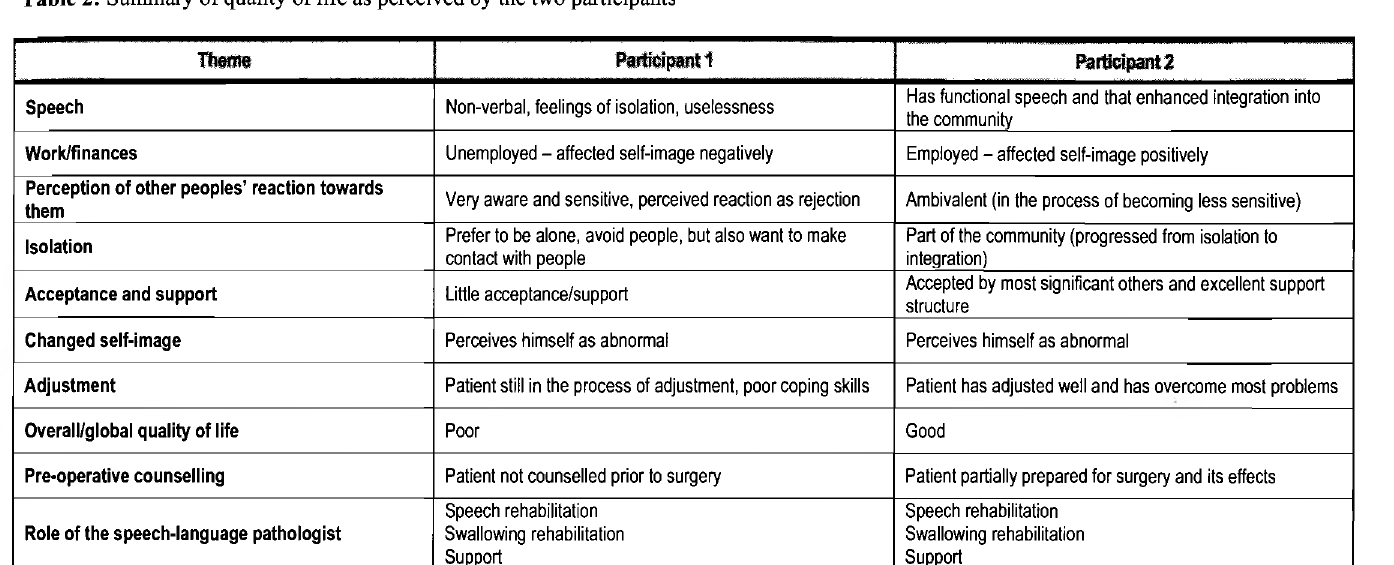
Table 2: Summary of quality of life as perceived by the two